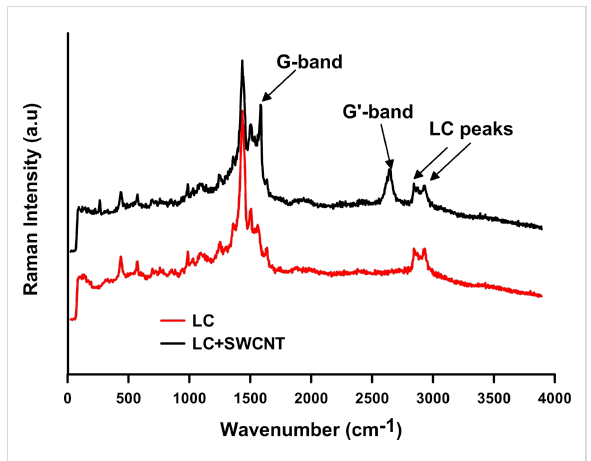
Figure 3: Raman spectra of a SWCNT-doped LC cell ( λ = 523 nm). The G and G’-bands are related to SWCNTs. The profile of the G-band should show a small peak in the case of metallic behavior. However, the Raman signal from the LC obstructs this peak.